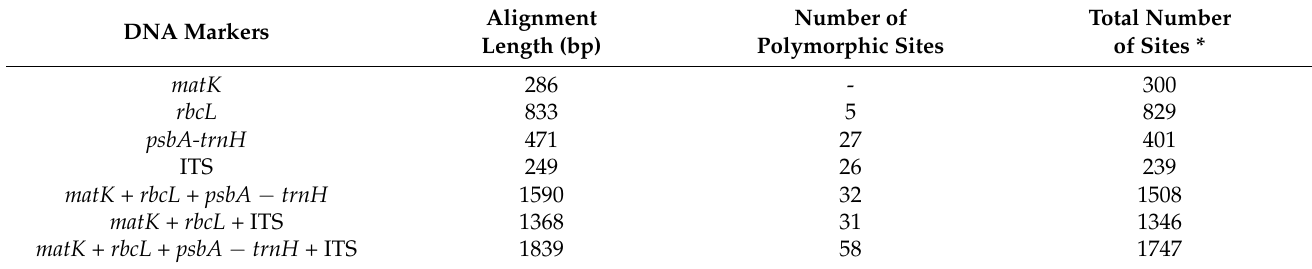
Table 2. Molecular characteristics of the four markers evaluated for Aniba species. Alignment DNA Markers Length (bp)